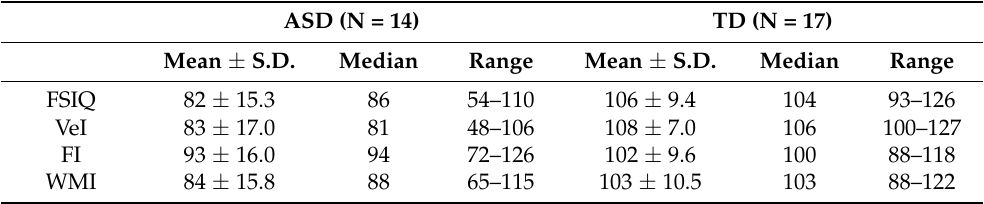
Table 1. Intellectual function at A1 by